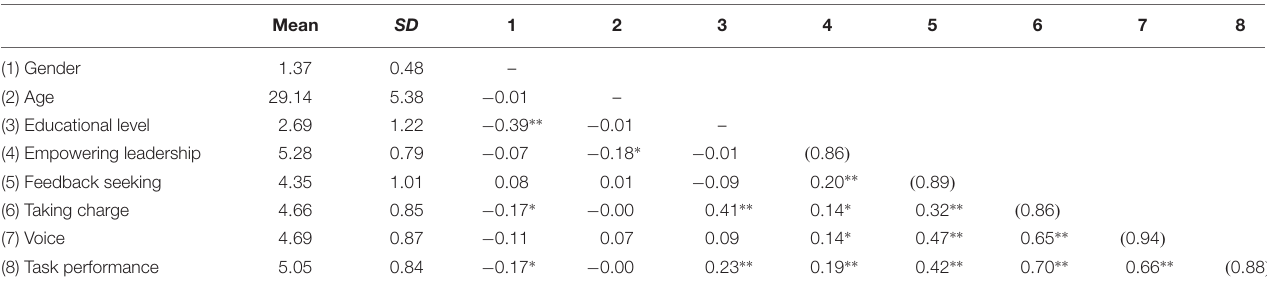
TABLE 2 | Means, standard deviations, reliabilities, and correlations among study variables.